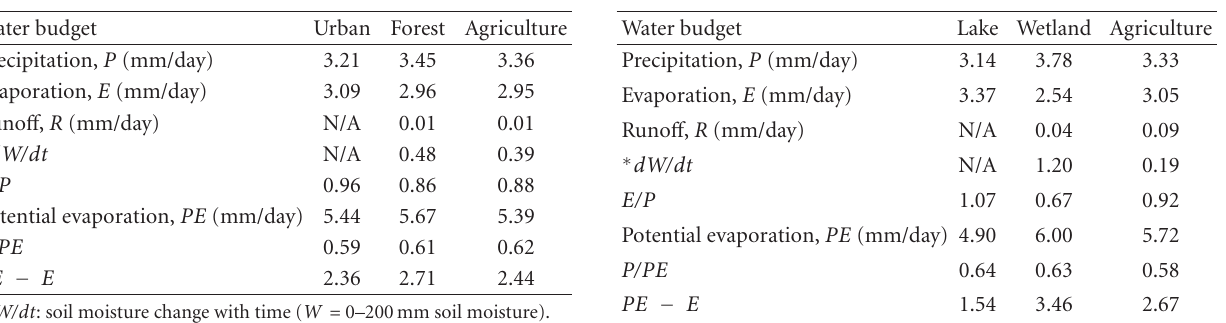
Table 2: Annual mean (1992–2001) water budget for various land use areas in South